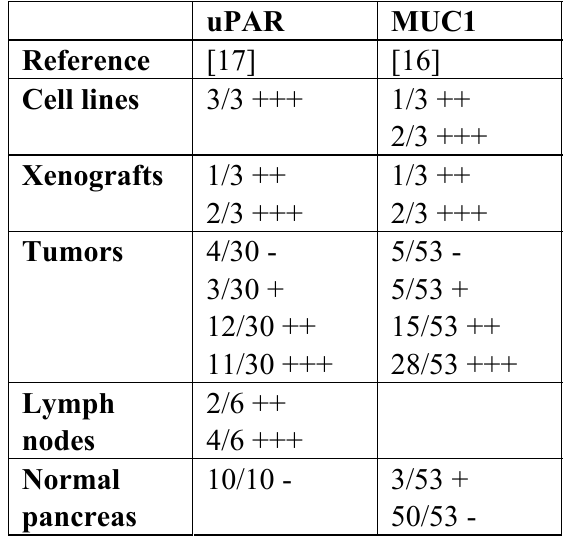
Table 1. Expression of uPAR and MUC1 in cell lines and tumor